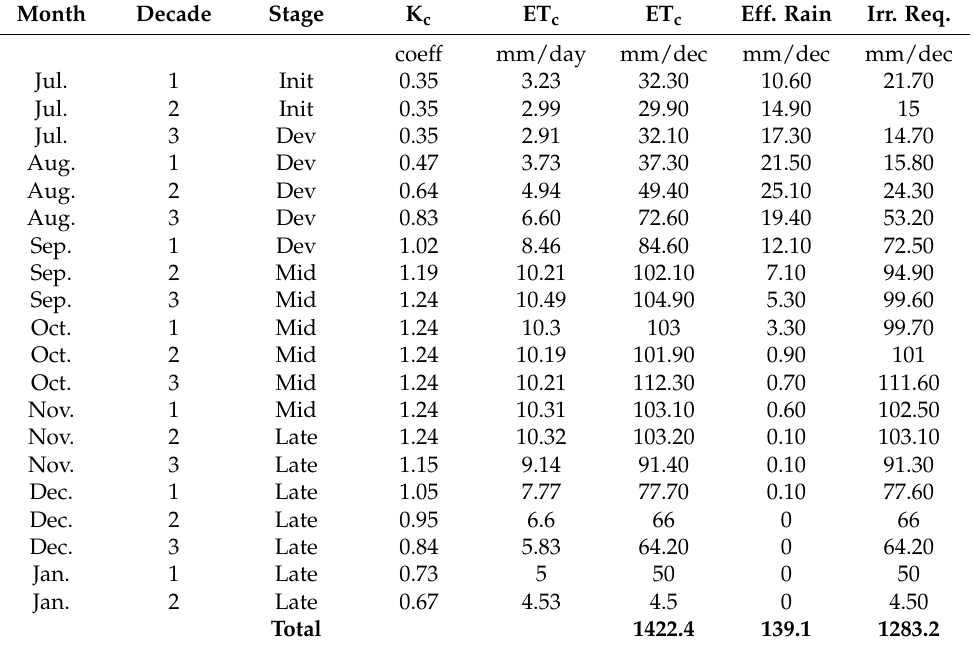
Table 5. Crop water requirements for cotton.